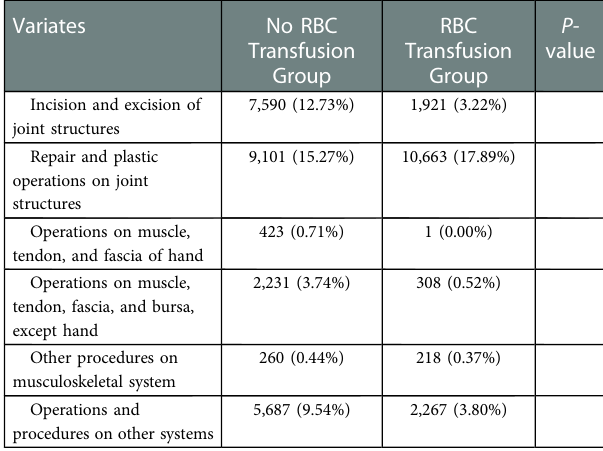
TABLE 1 Main preoperative characteristics of the study population of two groups (receiving postoperative RBC transfusion or